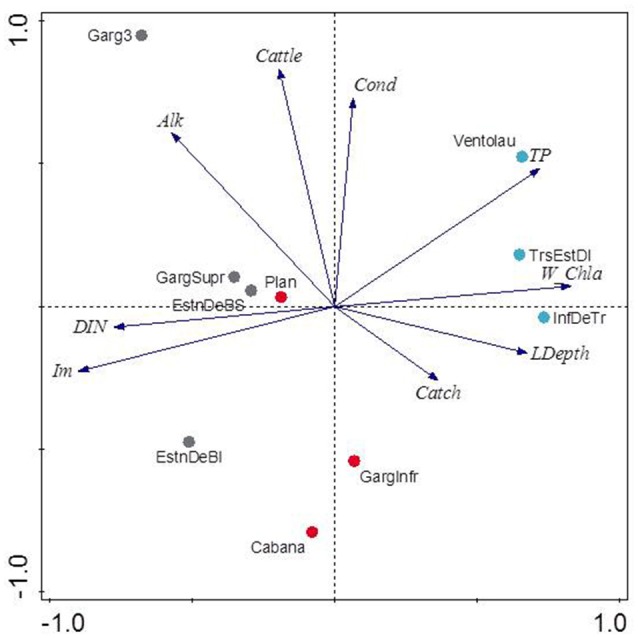
Principal Component Analysis (PCA) of the water column physico-chemistry and morphological parameters from ten lakes. Gray symbols are fishless lakes, red as for lakes invaded with trout and blue as for lakes invaded with dense minnow populations. Percentage of the variance explained by the first two axes is 39.9% and 22.2%, respectively. See Table 1 for variables abbreviation and Annex 1 Supplementary Materials for the score values. Lake name abbreviations are as follow: Bacivèr Superior (EstnDeBS), Bacivèr Inferior (EstnDeBI), Gargolhes 3 (Garg3), Gargolhes Superior (GargSupr), La Cabana (Cabana), Plan, Gargolhes Inferior (GargInfr), Inferior 3 Estanys (InfDeTr), Tres Estanys Mig (TrsEstDI), Ventolau.